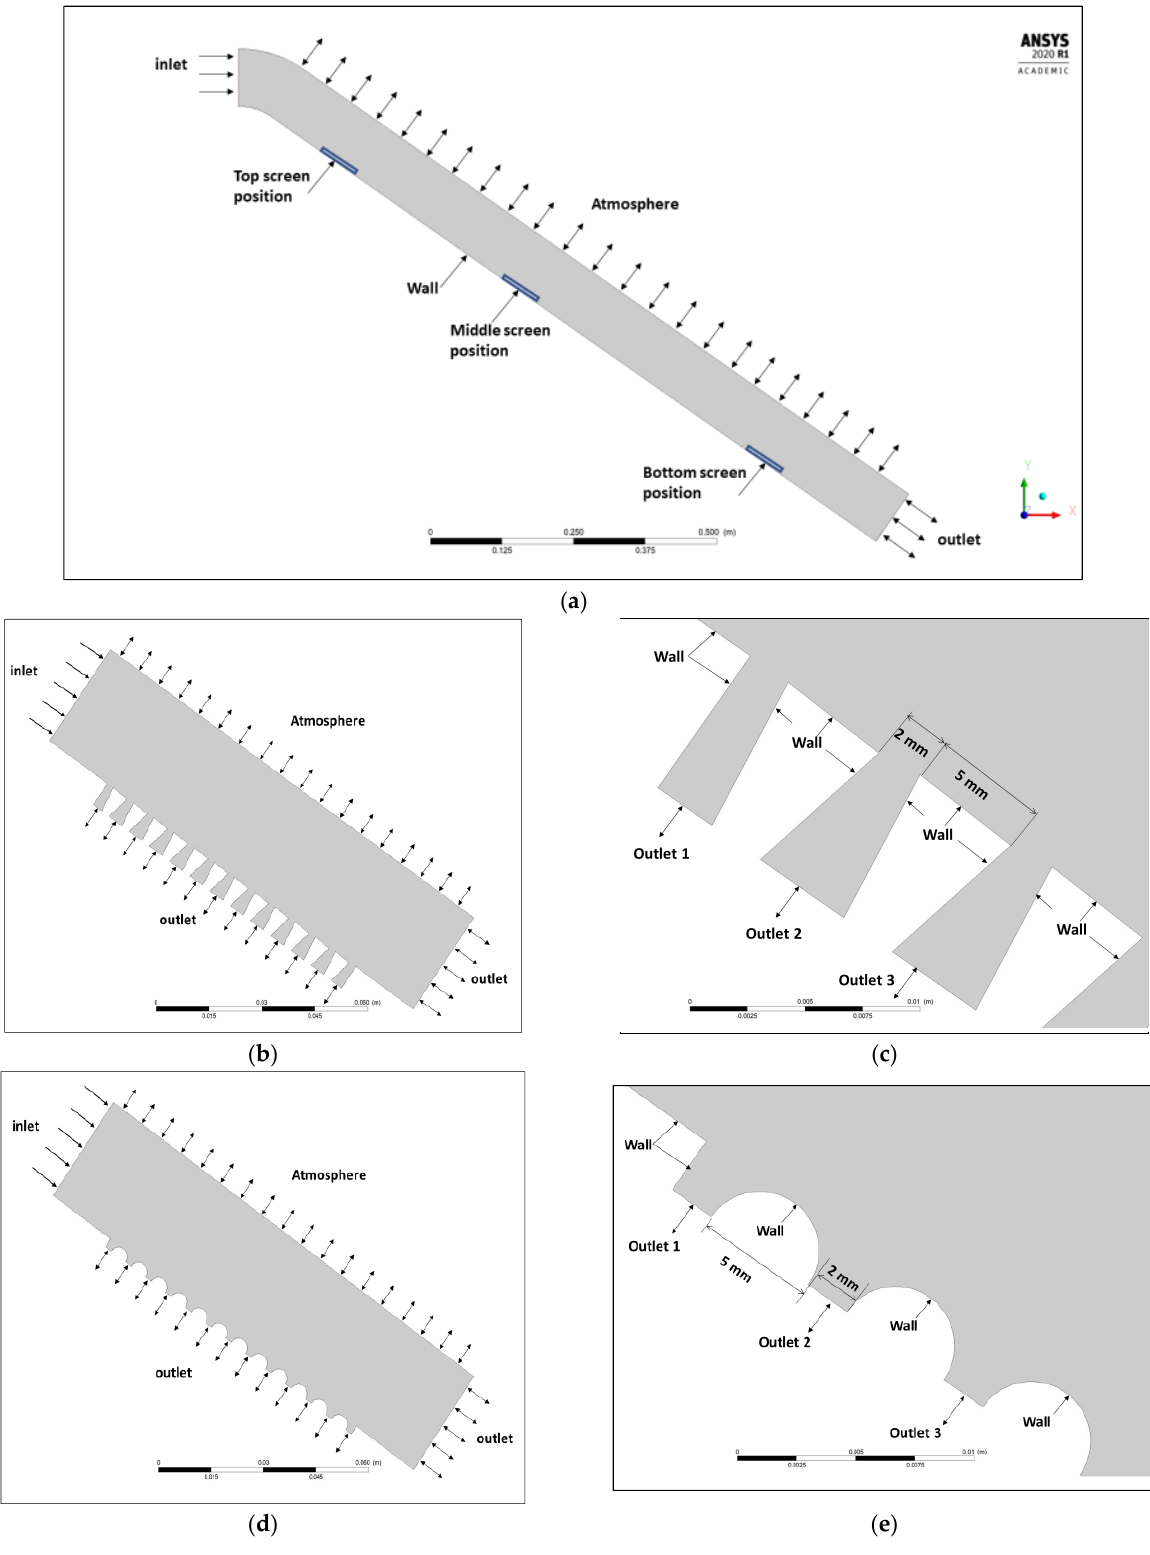
Figure 3. Geometry 2D of computational domain: ( a ) flume; ( b , c ) triangular wire screen; ( d , e ) circular wire screen.